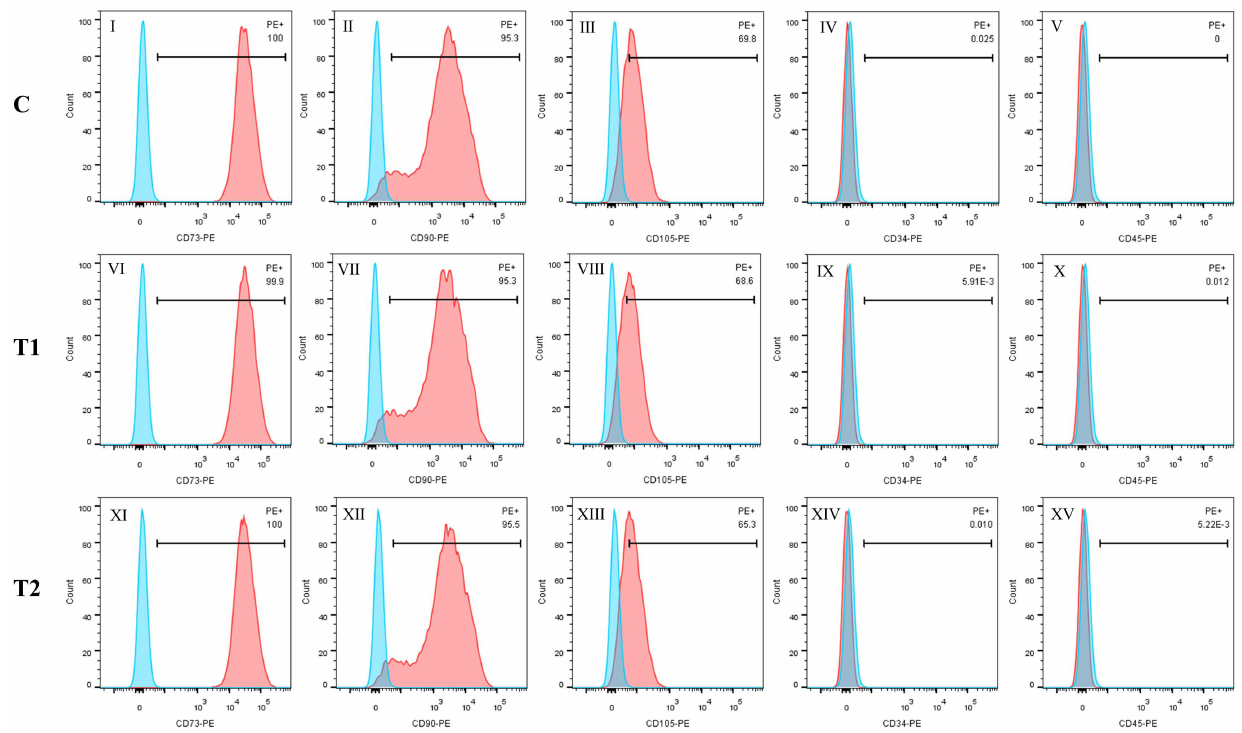
Figure 3. Identification of MSCs by flow cytometry in each group. I–V: C group; VI–X: T1 group; XI–XV: T2 group. The expression of CD73, CD90 and CD105 was positive; otherwise, CD45 and CD34 expression was negative in the three